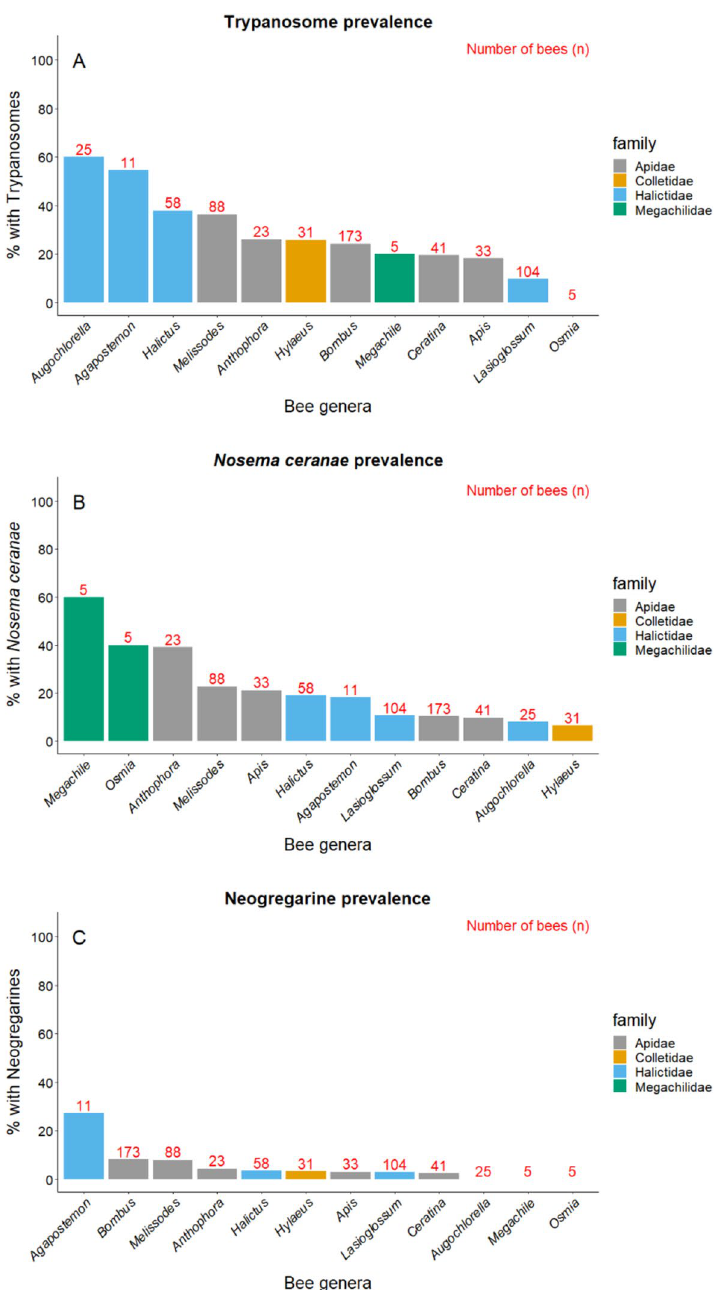
Figure 1. Prevalence of ( A ) trypanosomes, ( B ) Nosema ceranae , and ( C ) neogregarines among bee genera. The genera are ordered by decreasing prevalence within families. Differences were significant ( P < 0.05) for trypanosomes and N. ceranae (post-hoc comparisons in Table S4). Genera with fewer than 5 individuals screened are excluded from